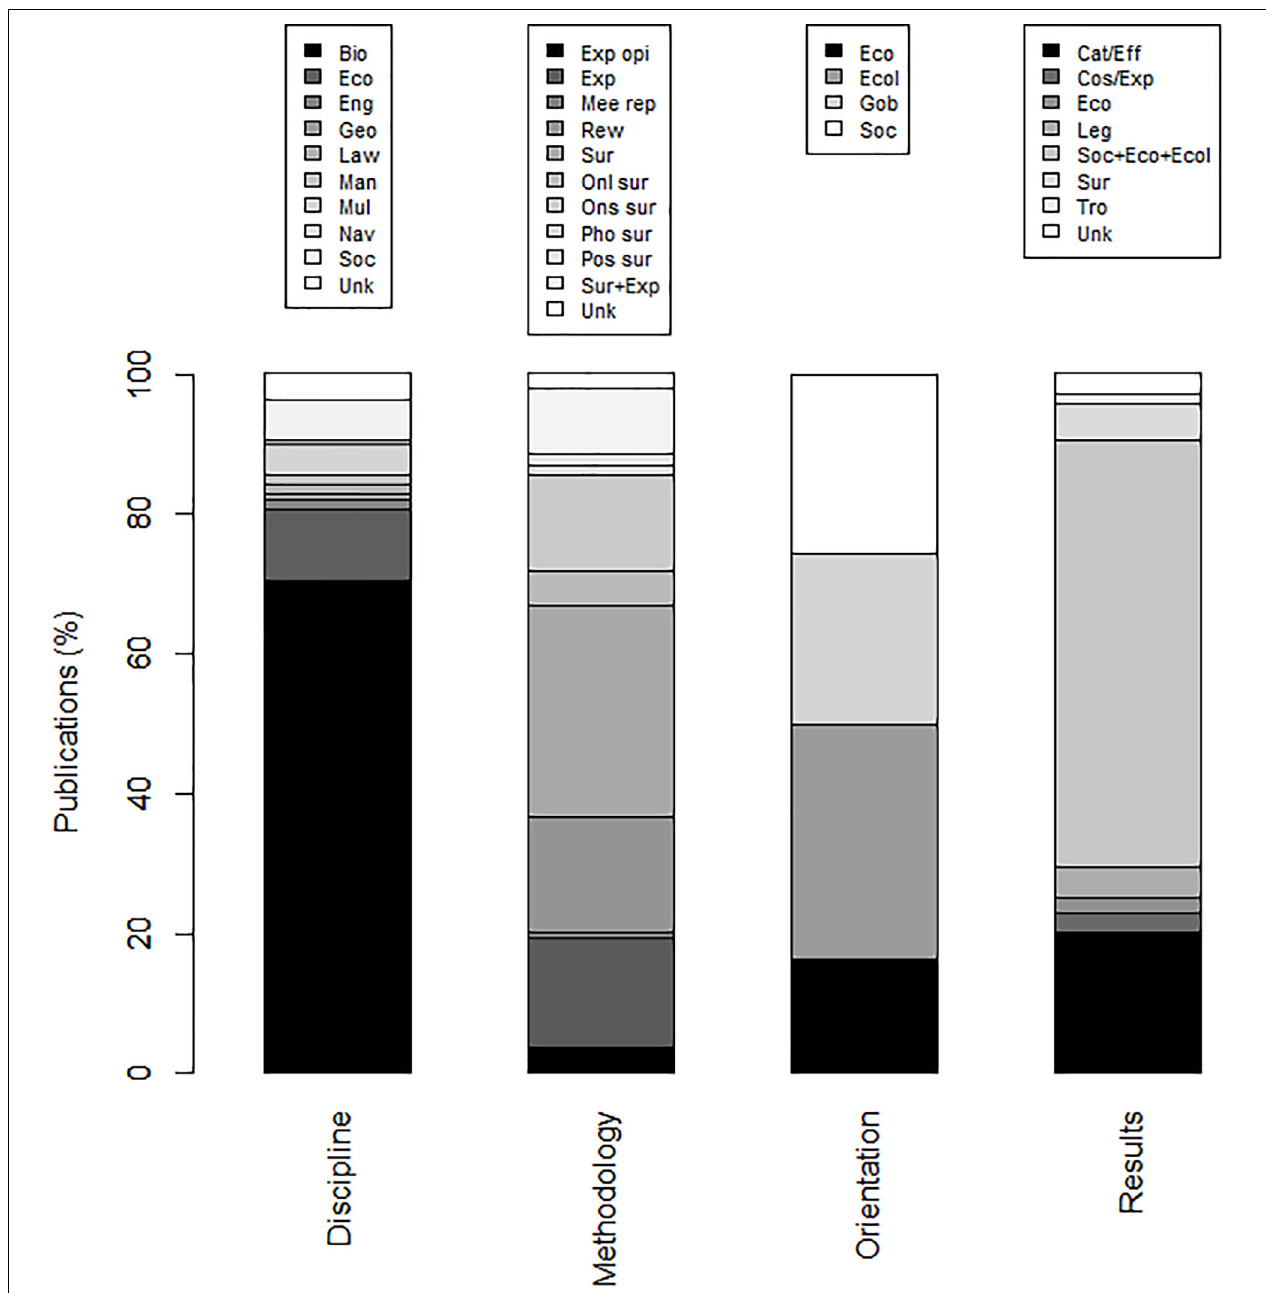
FIGURE 3 | Research studies about marine recreational fisheries in Spain obtained from scientific texts published up to 2018. The discipline of the first author (Bio, biology; Eco, economics; Eng, engineering; Geo, geography; Law, laws; Man, management; Mul, multidisciplinar; Nav, navigation; Soc, sociology; Unk, unknown), main methodology (Exp opi, expert opinion; Exp, experiments; Mee rep, meeting report; Rew, review; Sur, surveys (in general); OnI sur, online surveys; Ons sur, onsite surveys; Pho sur, phone surveys; Pos sur, postal surveys; Exp, experiments), major orientation (Ecol, ecological; Eco, economic; Gob, governance;